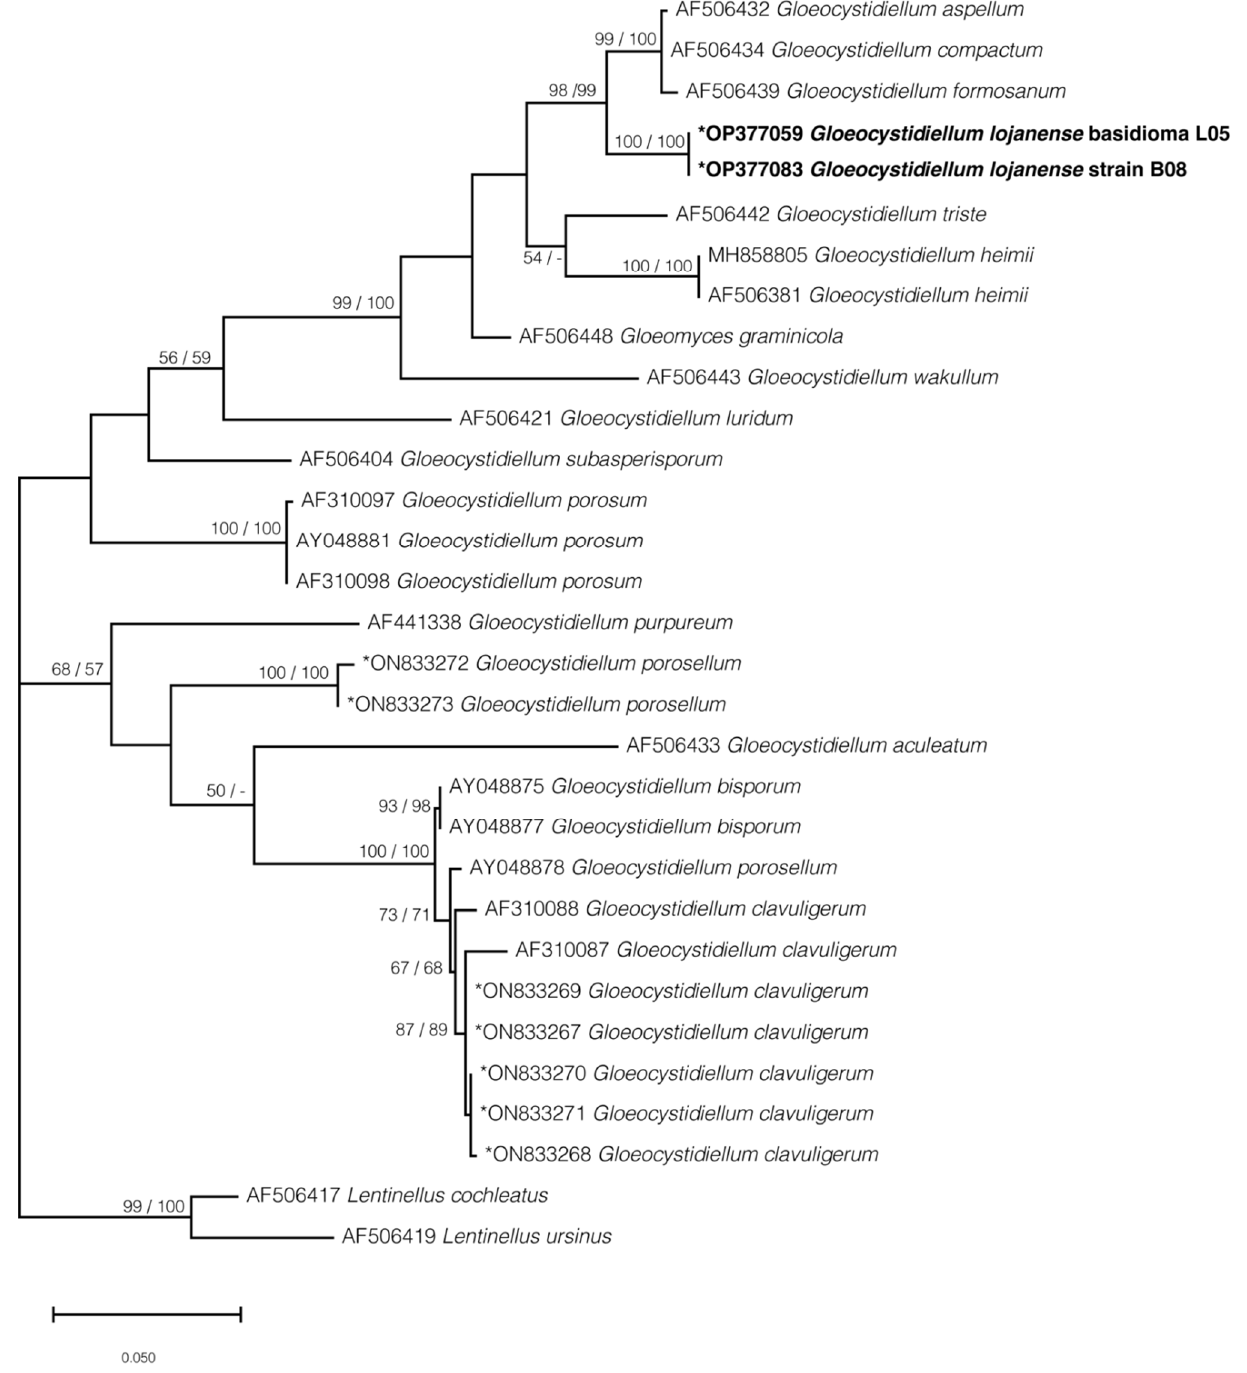
Figure 4. Concatenated maximum likelihood phylogenetic tree (ITS1-5.8S-ITS2 and partial LSU D1/D2) for sequence positioning corresponding to Gloeocystidiellum lojanense sp. nov. Values on the nodes correspond to ML and NJ, respectively. Bar = number of substitutions expected per position. * Sequences generated in this study. Sequences and accession numbers of the new species are in bold.